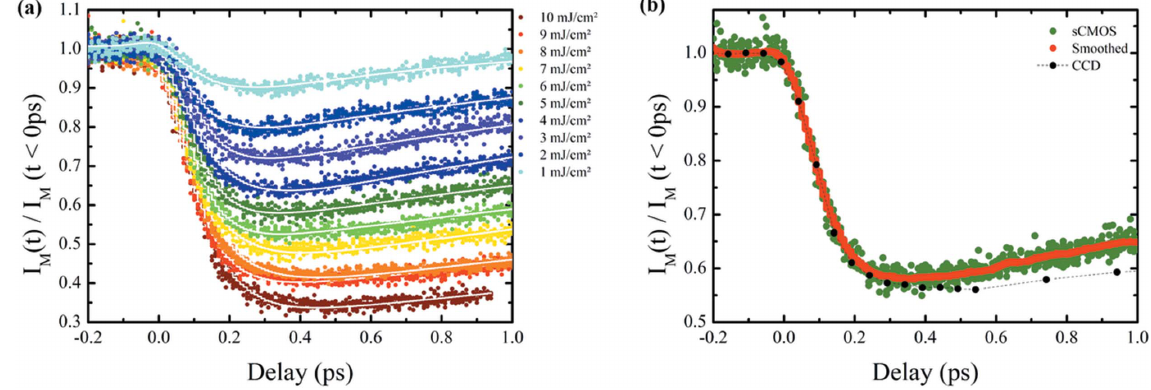
Figure 5 ( a ) Ultrafast demagnetization curves for different pump laser fluences with their respective fit curves in white. ( b ) Curves taken with the CMOS and CCD camera with laser fluences around 5 and 6.9 mJ cm (cid:3) 2 , respectively. The red line is a smoothed curve corresponding to the CMOS data (see text for details).